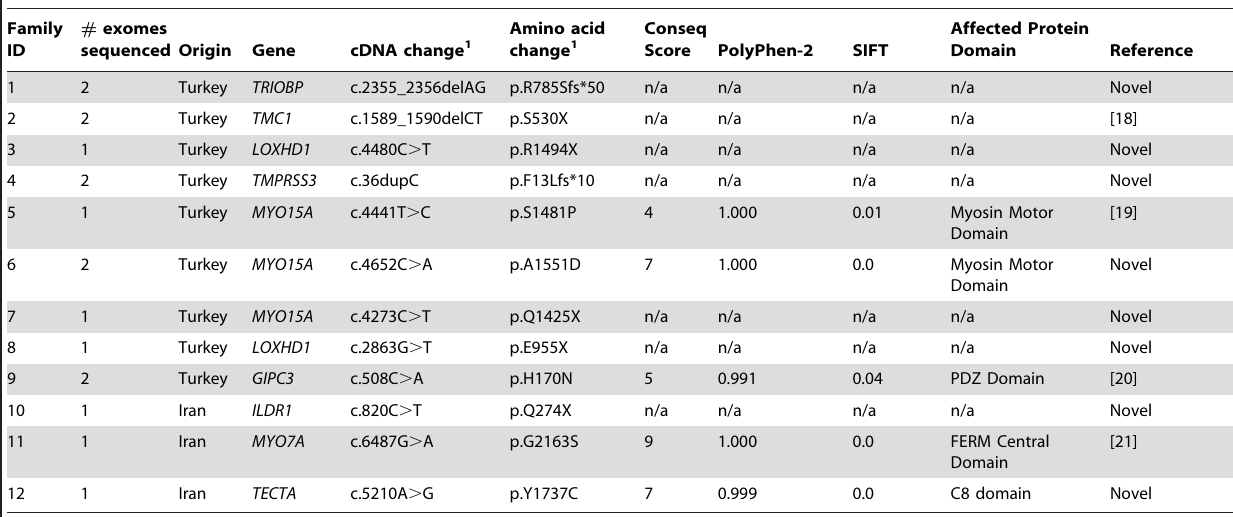
Table 1. Mutations identified in the ARNSHL-related genes.